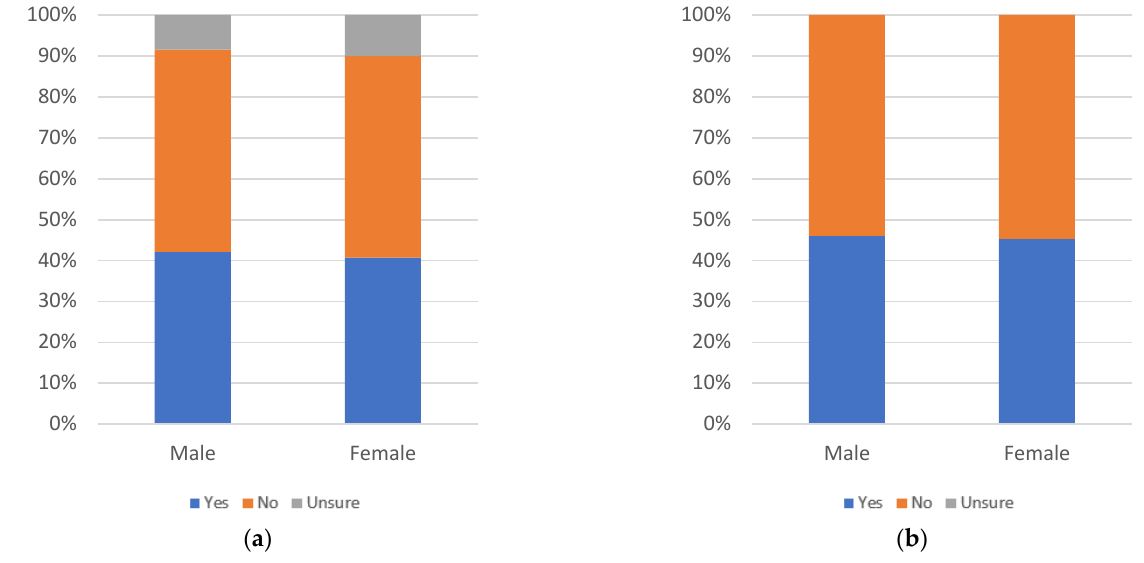
Figure 90. Label annoyingness, by gender: ( a ) with uncertain respondents (left) and ( b ) without uncertain respondents (right).